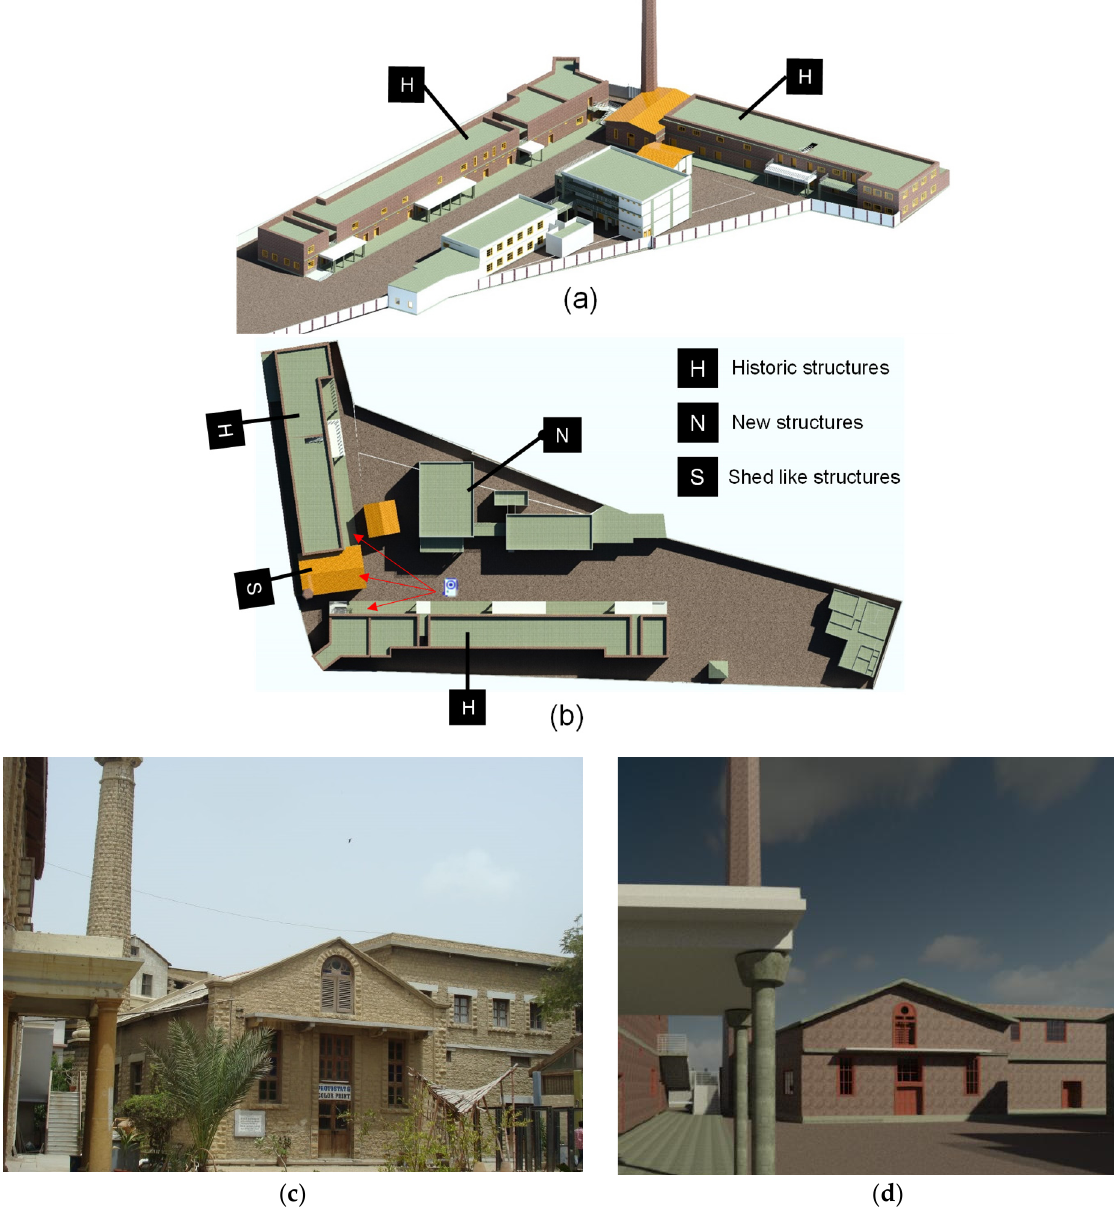
Figure 11. 3D HBIM model of the NED campus: ( a ) 3D BIM model of the case study; ( b ) top view of the case study model; ( c ) actual site picture of the shed-like structure captured by the authors; and ( d ) digital view of the shed-like structure.